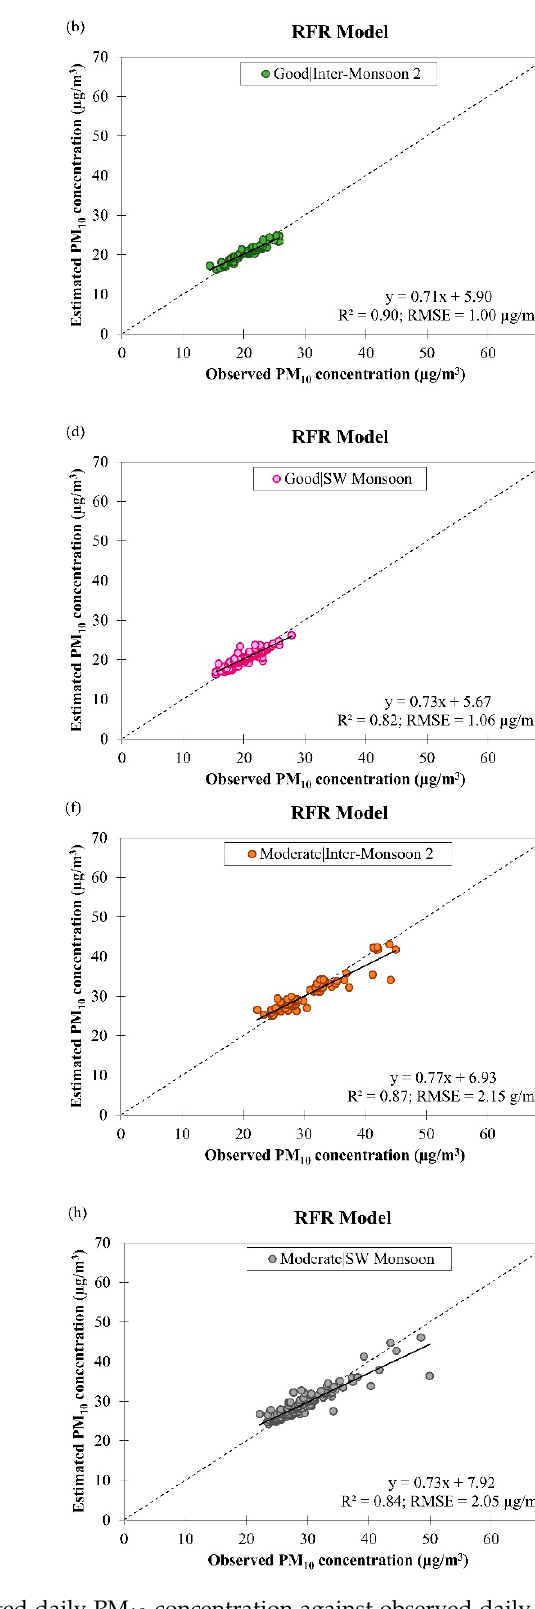
Figure 12. Scatter plots of estimated daily PM 10 concentration against observed daily PM 10 concen- tration by RFR model for ( a – d ) good and ( e – h ) moderate air quality conditions during different monsoon seasons in Singapore from March 2016 to February monsoon seasons in Singapore from March 2016 to February 2018.